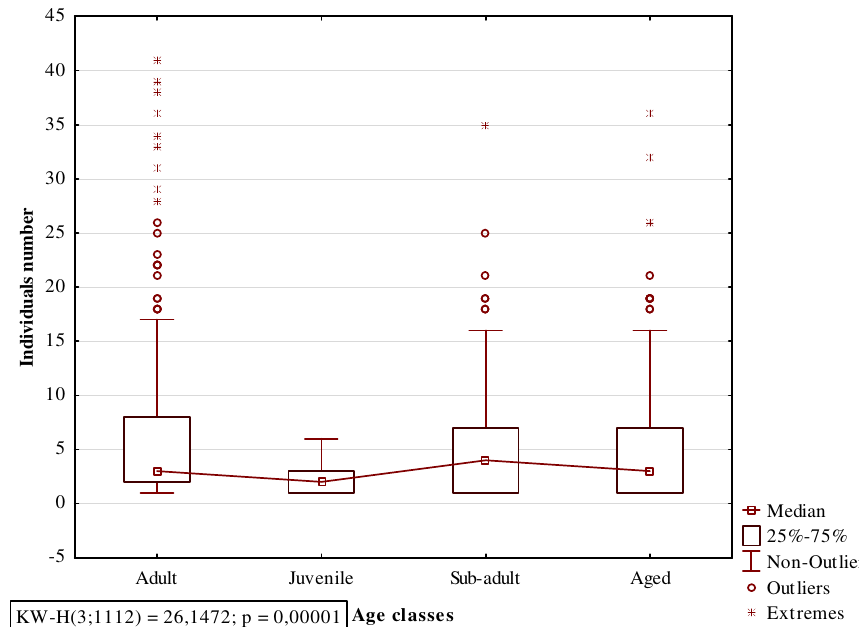
Figure 2. Individuals number of ectoparasites depending on black rats’